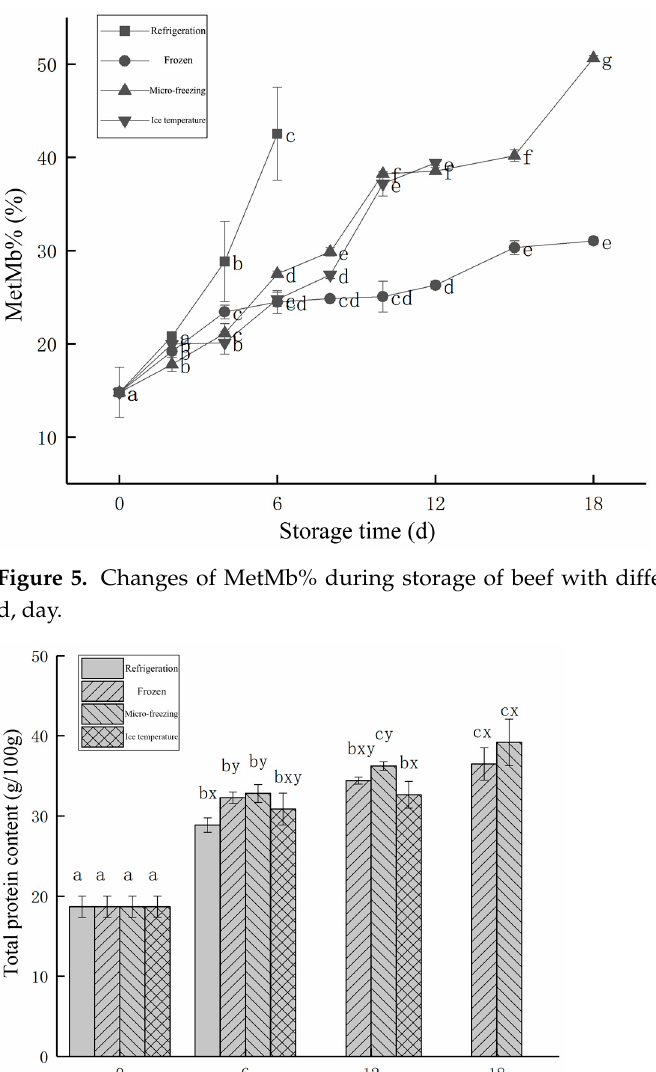
Figure 7. Changes in total sulfhydryl content during beef storage with different low-temperature storage methods. d, day. The total sulfhydryl content in fresh beef myofibrillar protein was 4.19 μ mol/g. Fol- lowing 6 d of storage, the total sulfhydryl content in beef in refrigeration storage de- creased to 1.81 μ mol/g. It was significantly lower than the total sulfhydryl content in the